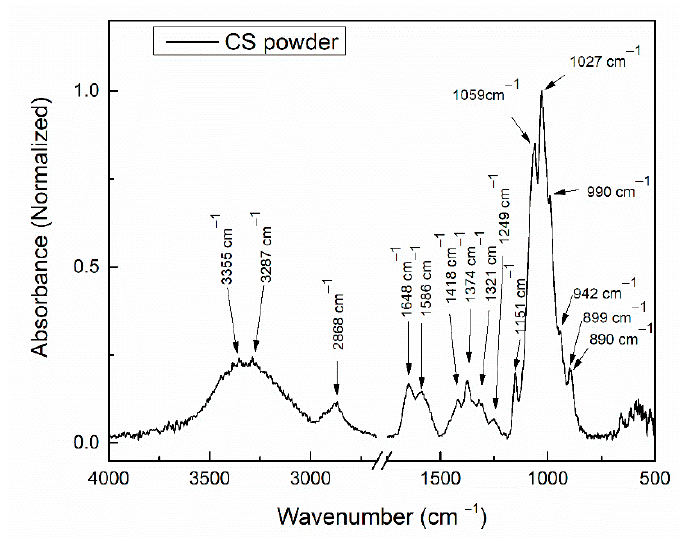
Figure 8. FTIR spectra of CS powder.